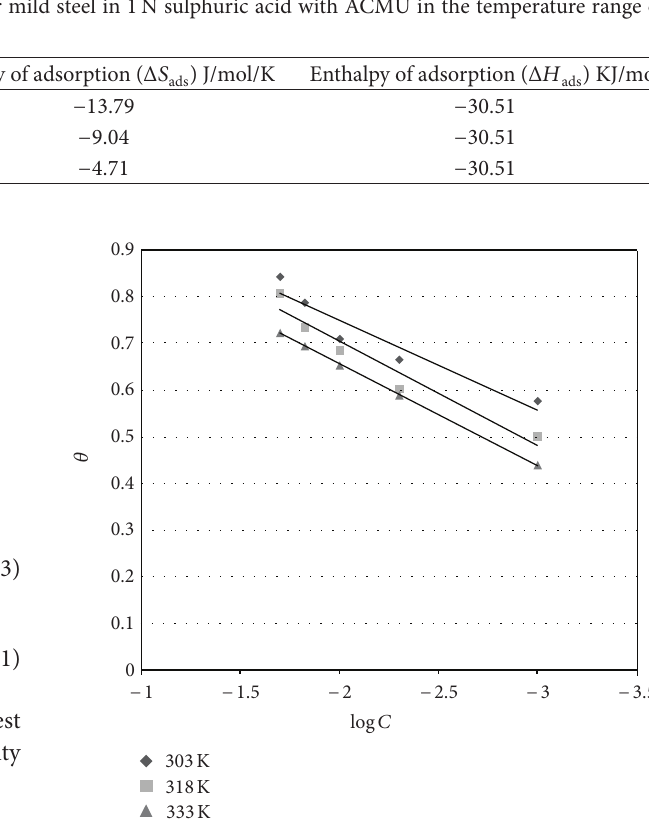
T 4: Data obtained from Langmuir adsorption isotherm for mild steel in 1N sulphuric acid with ACMU in the temperature range of